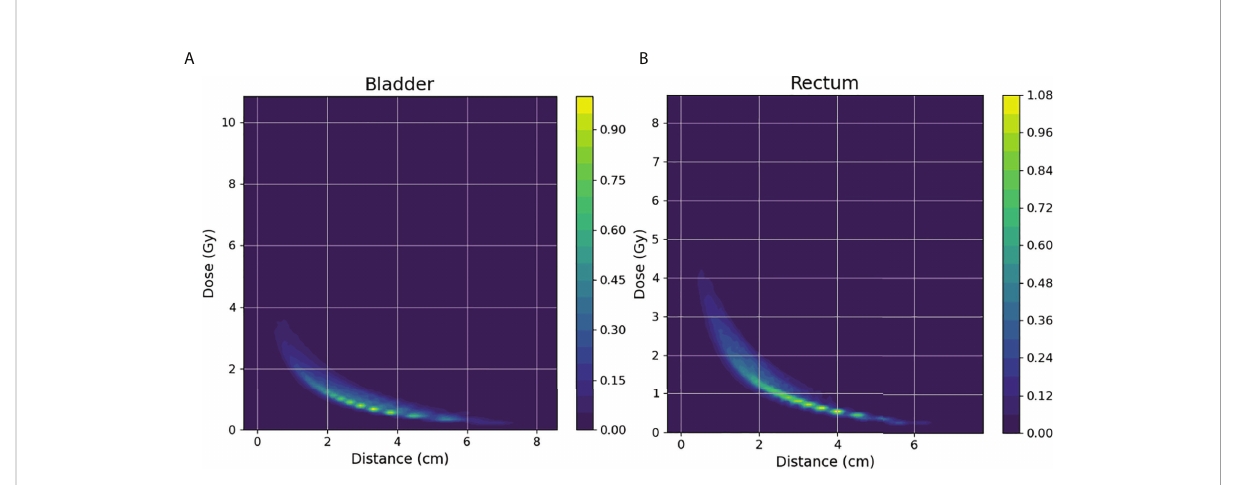
FIGURE 4 (A, B) depict the KDE model for bladder(left) and rectum(right) of 170 training